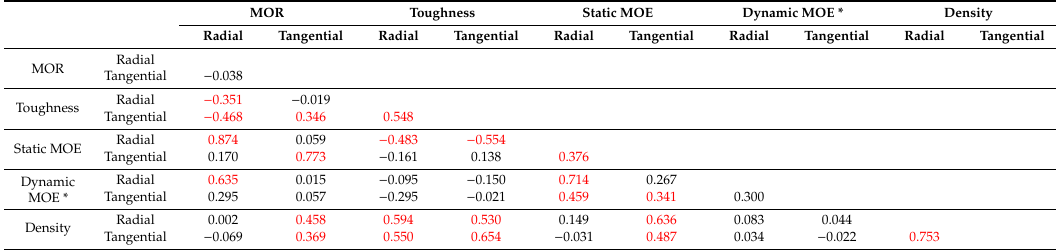
Table A7. Values of Correlation Coe ffi cients Between Given Quantities for Birch